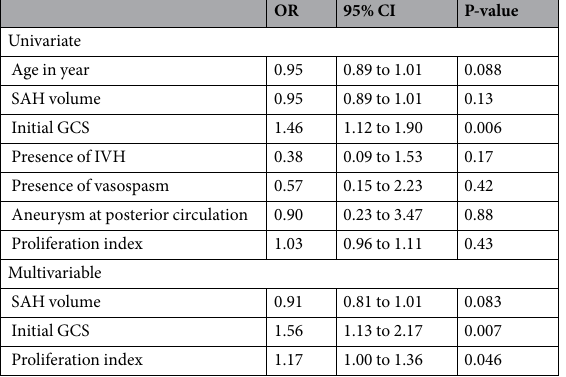
Table 2. Univariate and Multivariable analyses of determinants for favorable outcome in patients with subarachnoid hemorrhage. CI indicates confidence interval; SAH, subarachnoid hemorrhage; GCS, Glasgow coma scale; IVH, intraventricular hemorrhage; OR, odds ratio. The posterior circulation includes vertebral or basilar arteries, posterior cerebral artery, posterior communicating artery, and posterior inferior cerebellar artery. The model of multivariable analysis includes SAH volume, initial GCS, and the proliferation